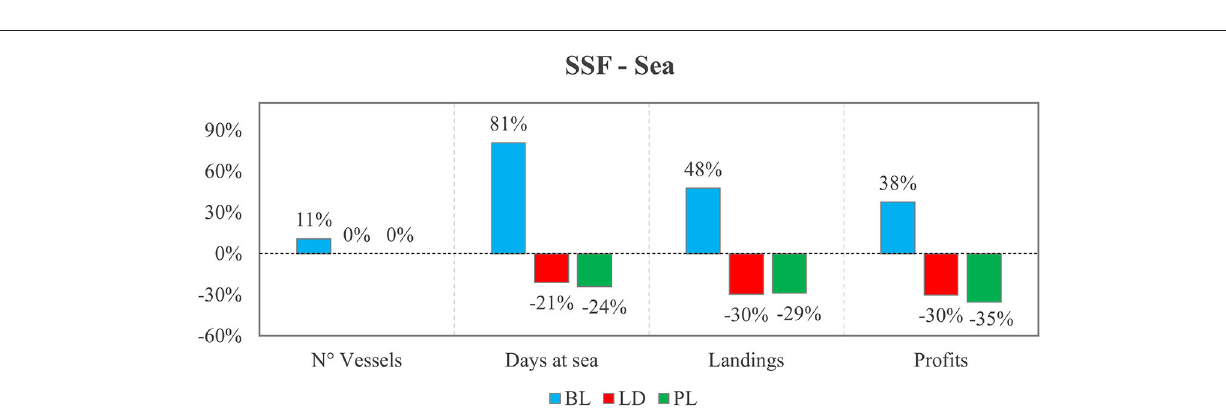
period. Differently, in LD and PL, a negative balance of about